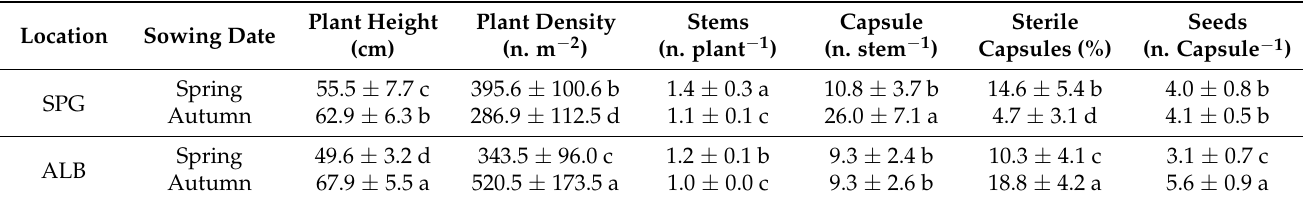
Table 5. Interaction effects of location (SPG and ALB) and sowing date (S: spring; A: autumn) on linseed plant height, plant density, number of stems per plant, number of capsules per stem, sterile capsule percentage and number of seeds per capsule. Data refer to mean values ± standard